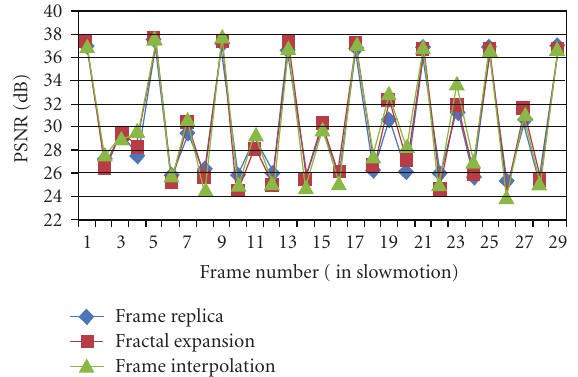
Figure 14: Measured PSNR (dB) for IntoTree (4 × slow motion).